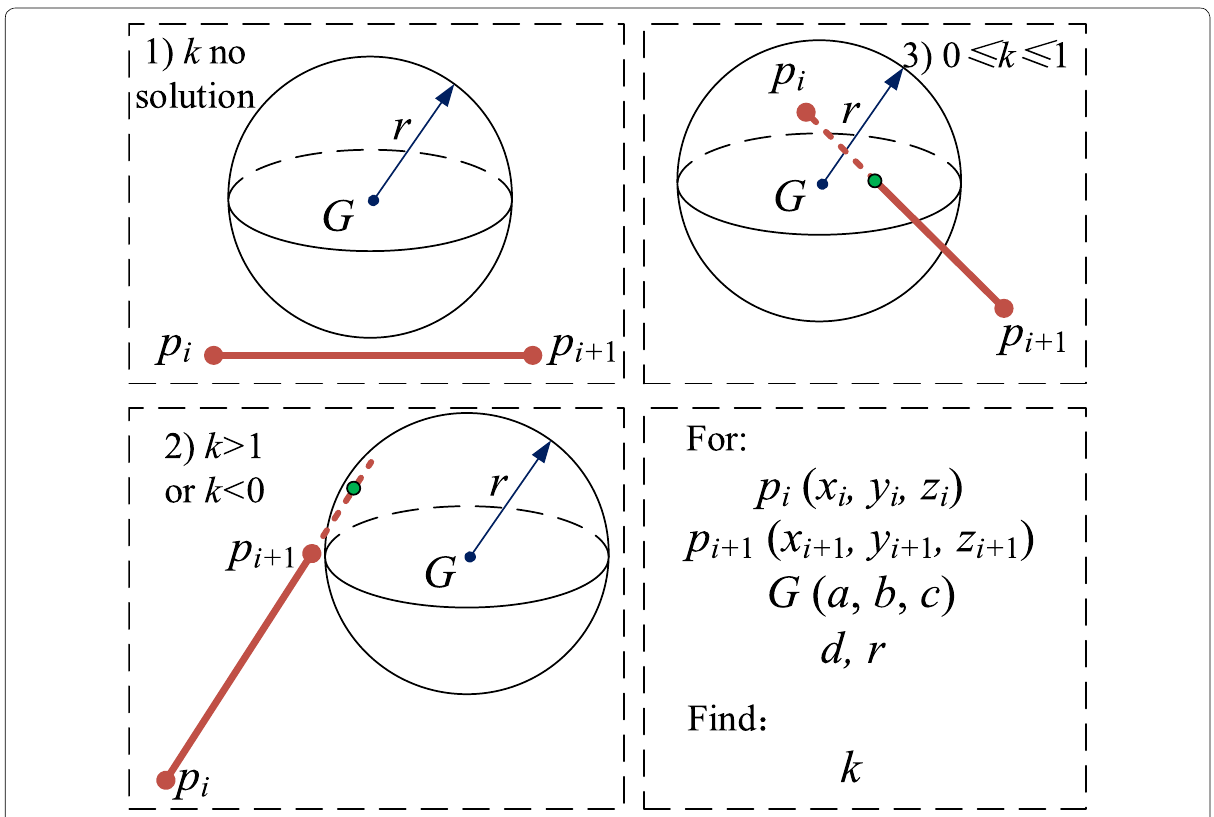
Figure 5 Relative positions of links and